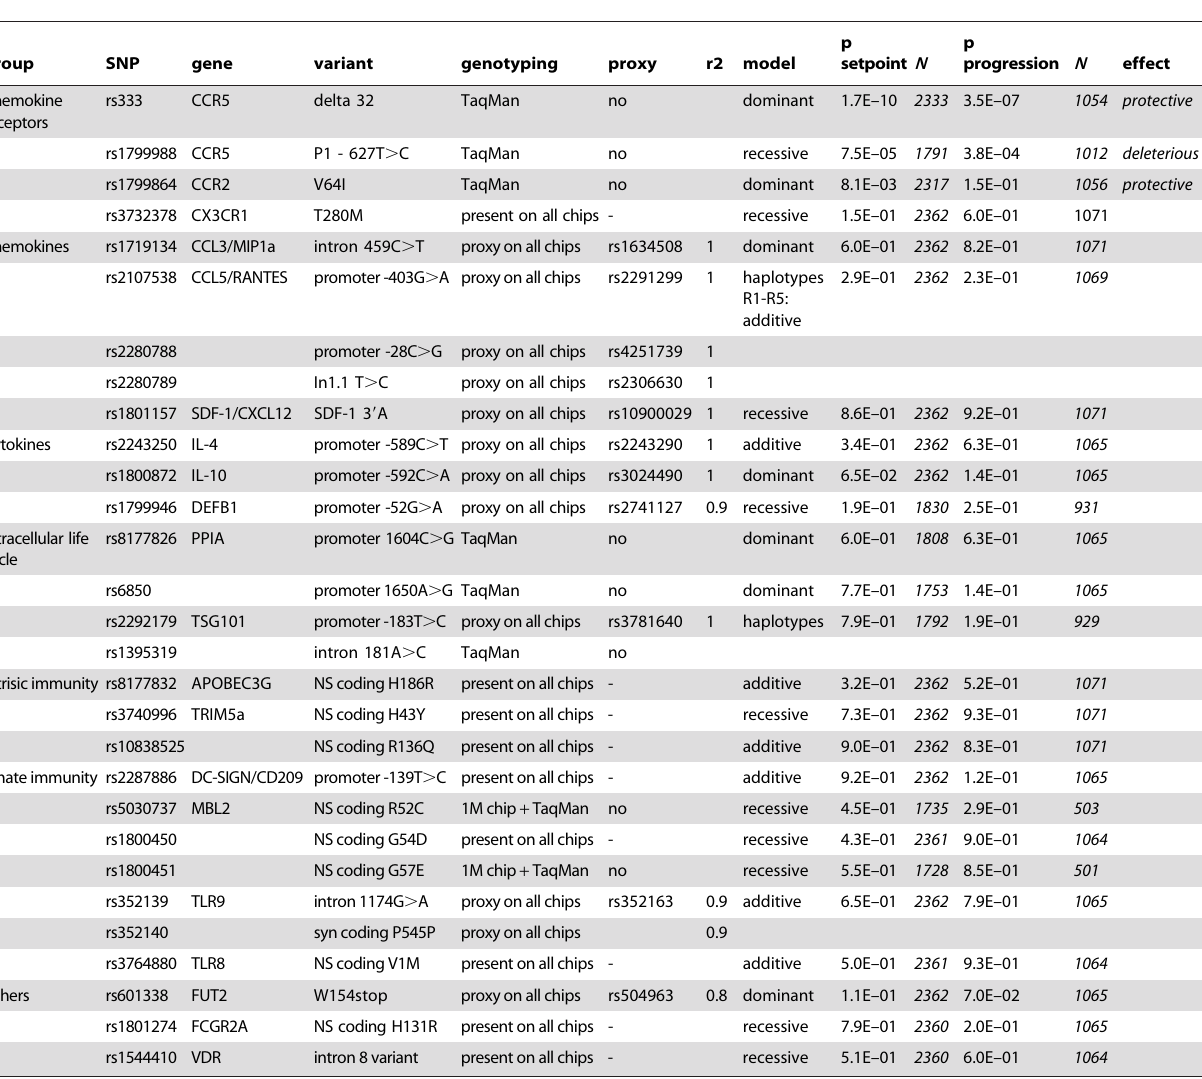
Table 3. Variants in HIV-1 candidate genes, previously reported to associate with viral control or disease progression.